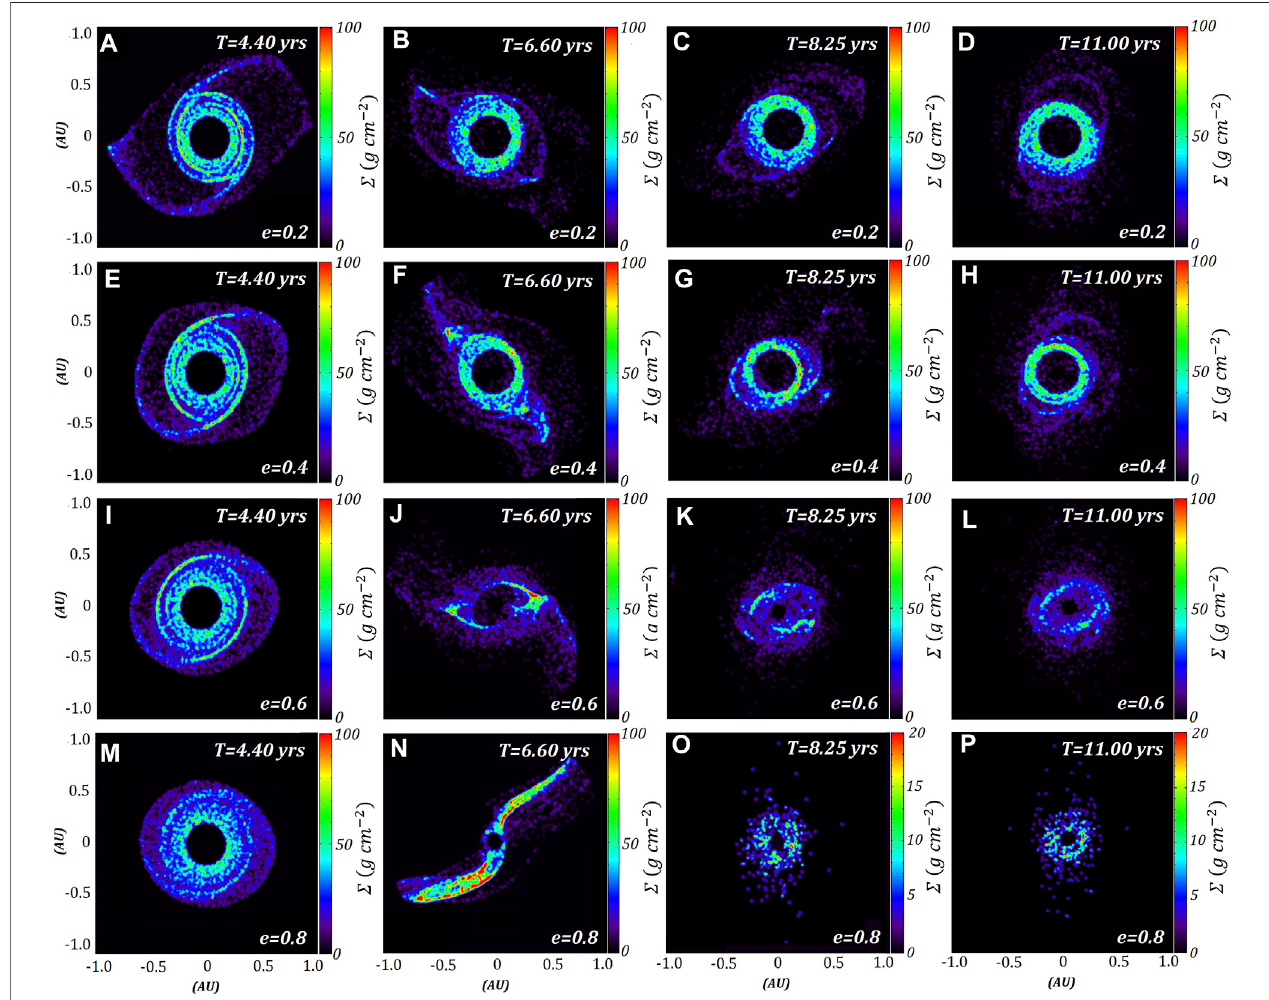
FIGURE2| Surfacedensitiesofthesamefourmodelsin Figure1 .Thexand y axesrepresenttheinstanteouspositionsofringparticlesaroundJ1407b,whichisat the origin. The rows represent each model, where e (cid:1) 0 . 2 (A – D) , e (cid:1) 0 . 4 (E – H) , e (cid:1) 0 . 6 (I – L) and e (cid:1) 0 . 8 (M – P) , while the column represents a snapshot in time at T (cid:1) 4 . 40 yrs ( A , E , I & M ) , T (cid:1) 6 . 60 yrs ( B , F , J & N ) , T (cid:1) 8 . 25 yrs ( C , G , K & O ) , T (cid:1) 11 . 00 yrs ( D , H , L & P ) , where all models began at apocentre.